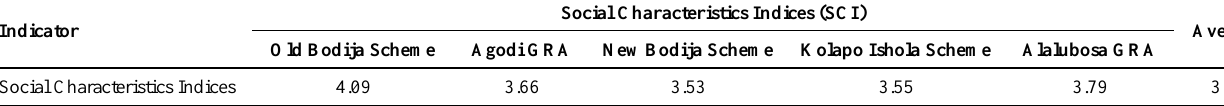
Table 13. Summary of the Perception of the Social Characteristics Indices (SCI) in the Study Areas